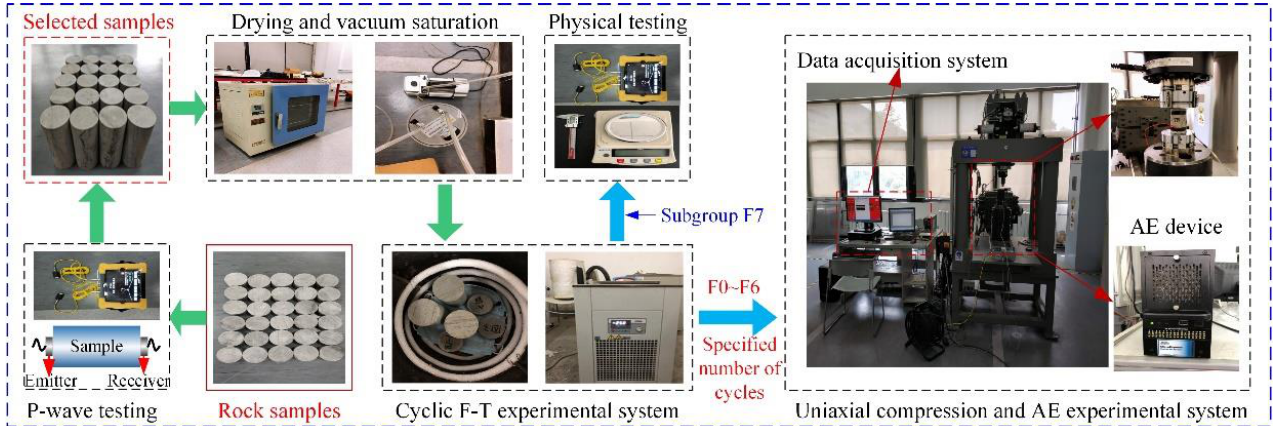
Figure 4. Experimental procedure and equipment. Table 1. The physical parameters of the selected samples.